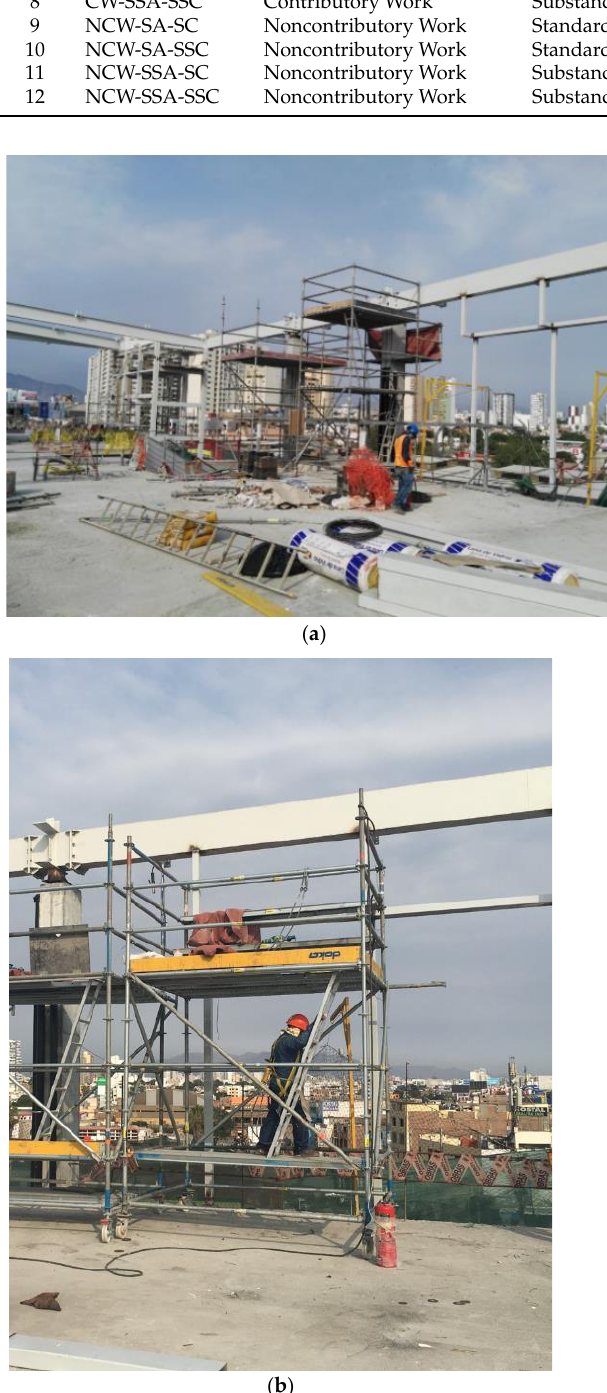
Figure 1. ( a ) Standing worker (NCW-SA-SSC); ( b ) Using scaffolding (CW-SA-SSC).